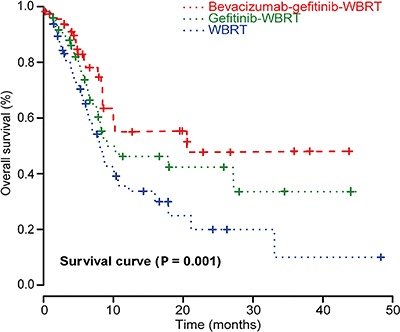
Kaplan-Meier estimation of overall survival rate in patients with brain metastases due to non-small-cell lung cancer treated with bevacizumab-gefitinib-WBRT, gefitinib-WBRT and WBRT. WBRT: whole brain radiotherapy.